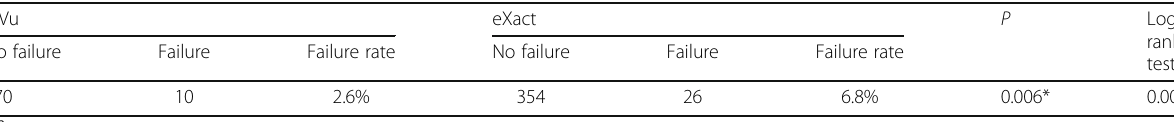
Table 2 Bond failure rates InVu eXact testNo